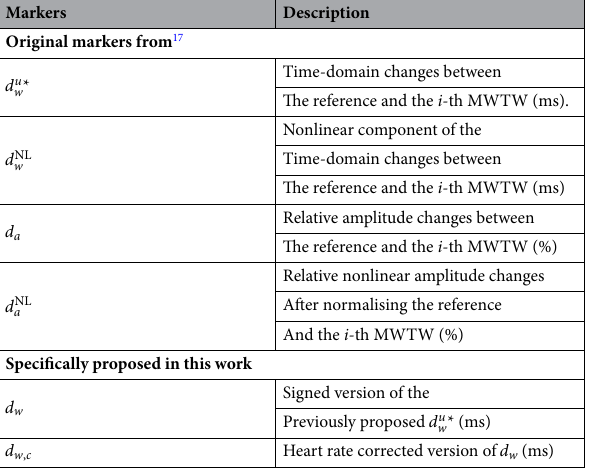
Table 3. T-wave morphology markers for [ K + ] monitoring. * d u w correspond to the marker denoted as d w in 17 , while here. d w is reserved for the newly introduced signed version.